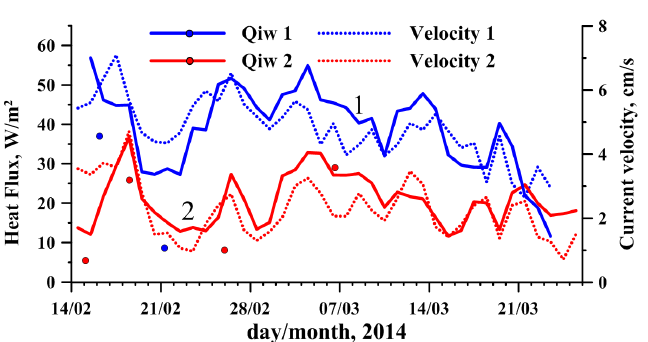
Figure 12. Daily averaged heat fluxes at the ice–water interface (solid lines) calculated from heat balance Equations (2), (4) and (5) and current velocities (dashed lines) at Station 1 (blue lines) and Station 2 (red lines); the circles are instantaneous values of heat fluxes determined by the temperature gradient in the thin under-ice water layer when thermal sensors froze in the ice